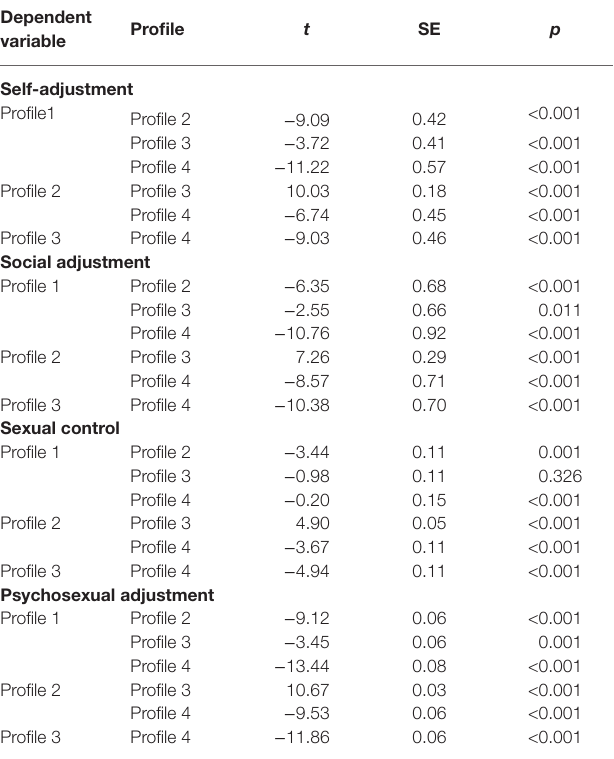
TABLE 4 | Hierarchical linear models ( n = 1,075).